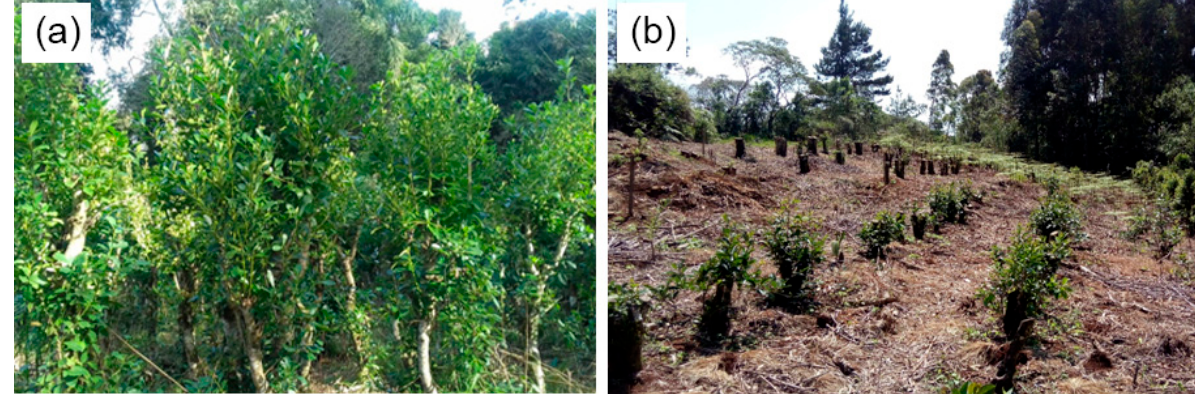
Figure 2. Yerba-mate plants before ( a ) and after ( b ) the experimental intervention.